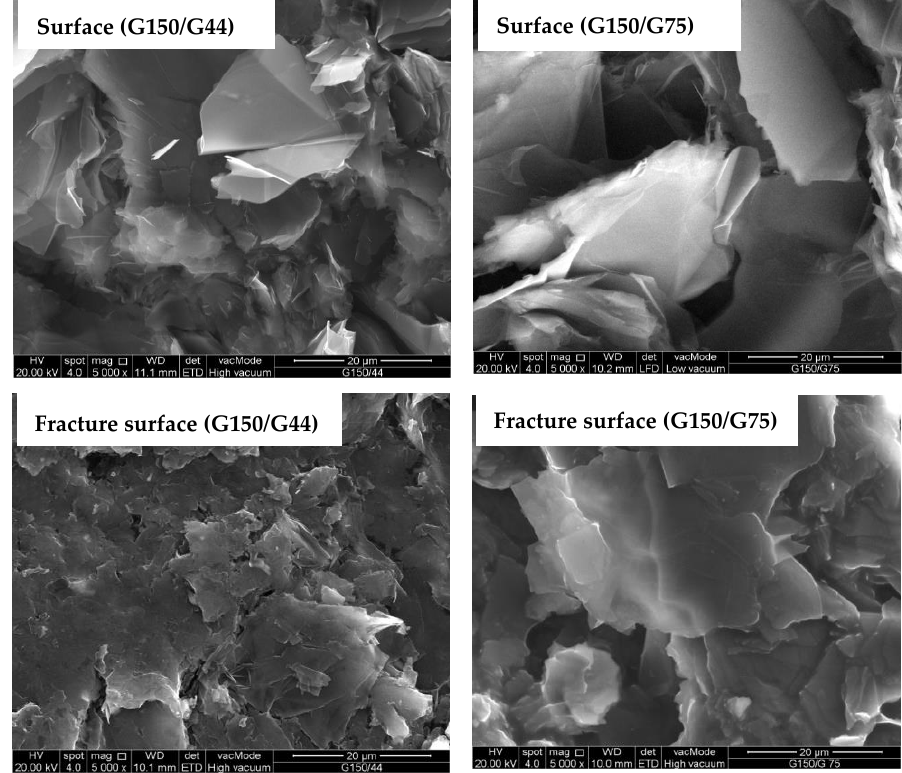
Figure 4. SEM surface and fracture surface images of epoxy/G150/G75 and epoxy/G150/G44 at 80 wt.% overall filling load prepared at 150 °C for 120 min.